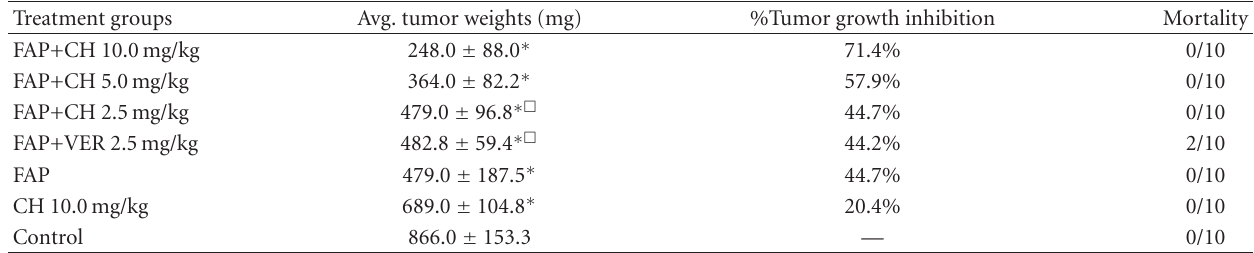
Table 1: The Tumor inhibition of the Hca/FAP solid tumor after treatment.